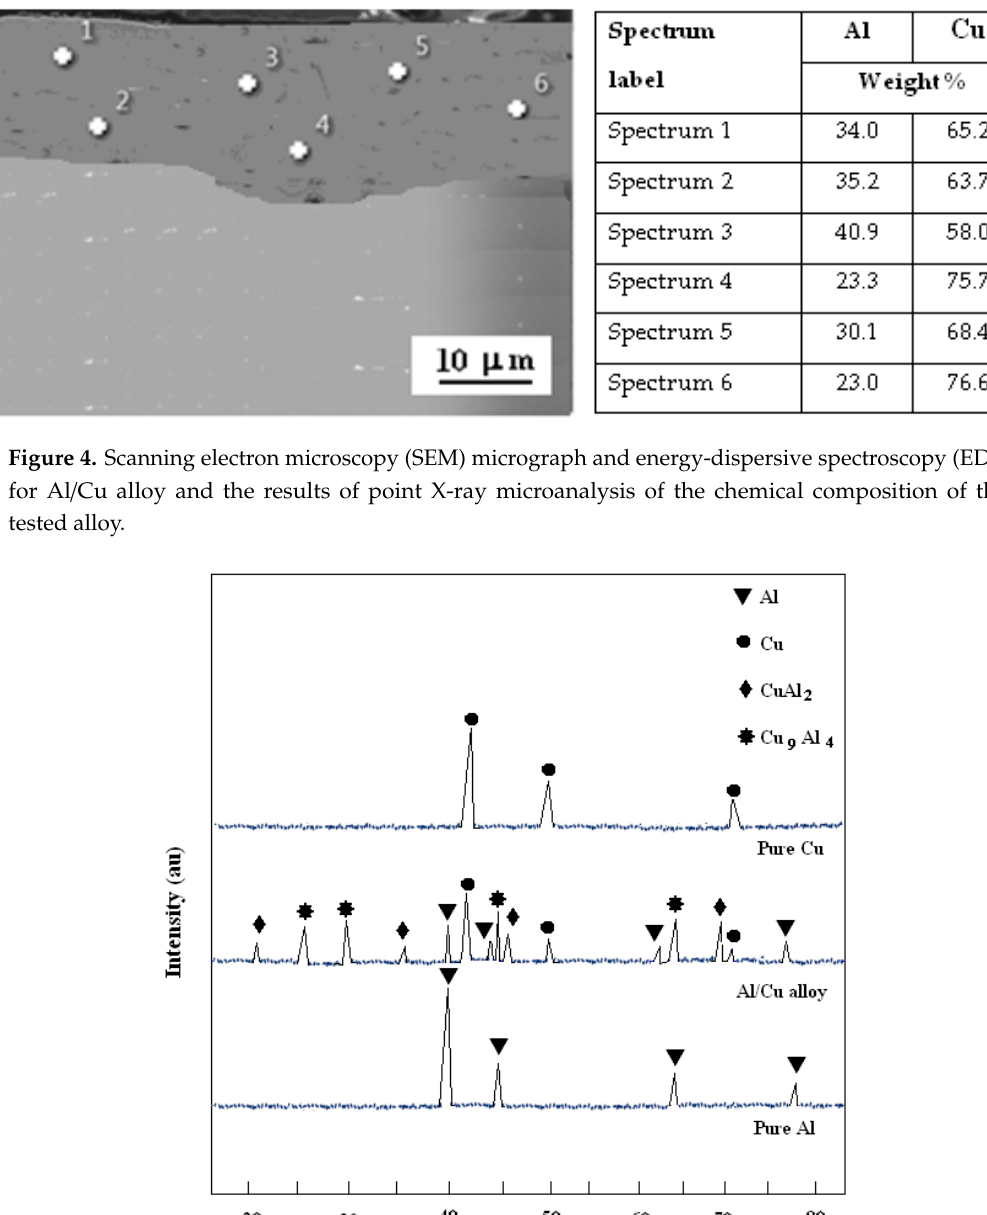
Figure 3. X-ray microanalysis of cross-section of Al/Cu alloy: ( a ) metallographic microstructure (with the line scanning) and content distribution: ( b ) aluminum and ( c ) copper.